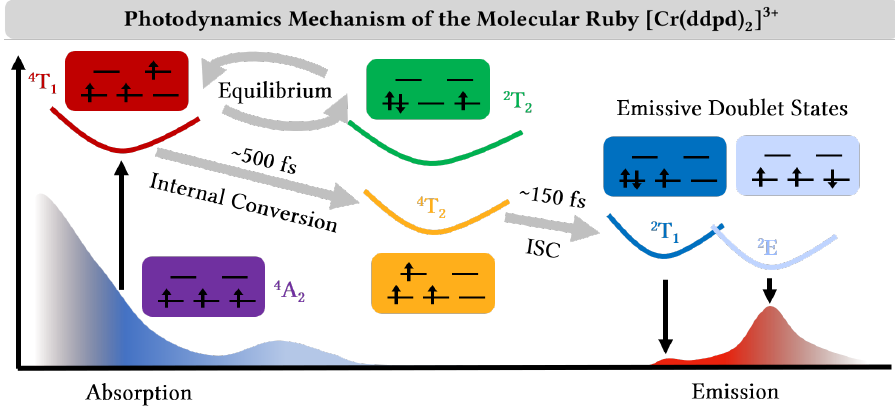
Figure 6. Summary of the photodynamics mechanism of the molecular ruby [Cr(ddpd) citation to the 4 T states and an initial equilibration with the 2 T 1 states and undergoes intersystem crossing (ISC) to the 2 T